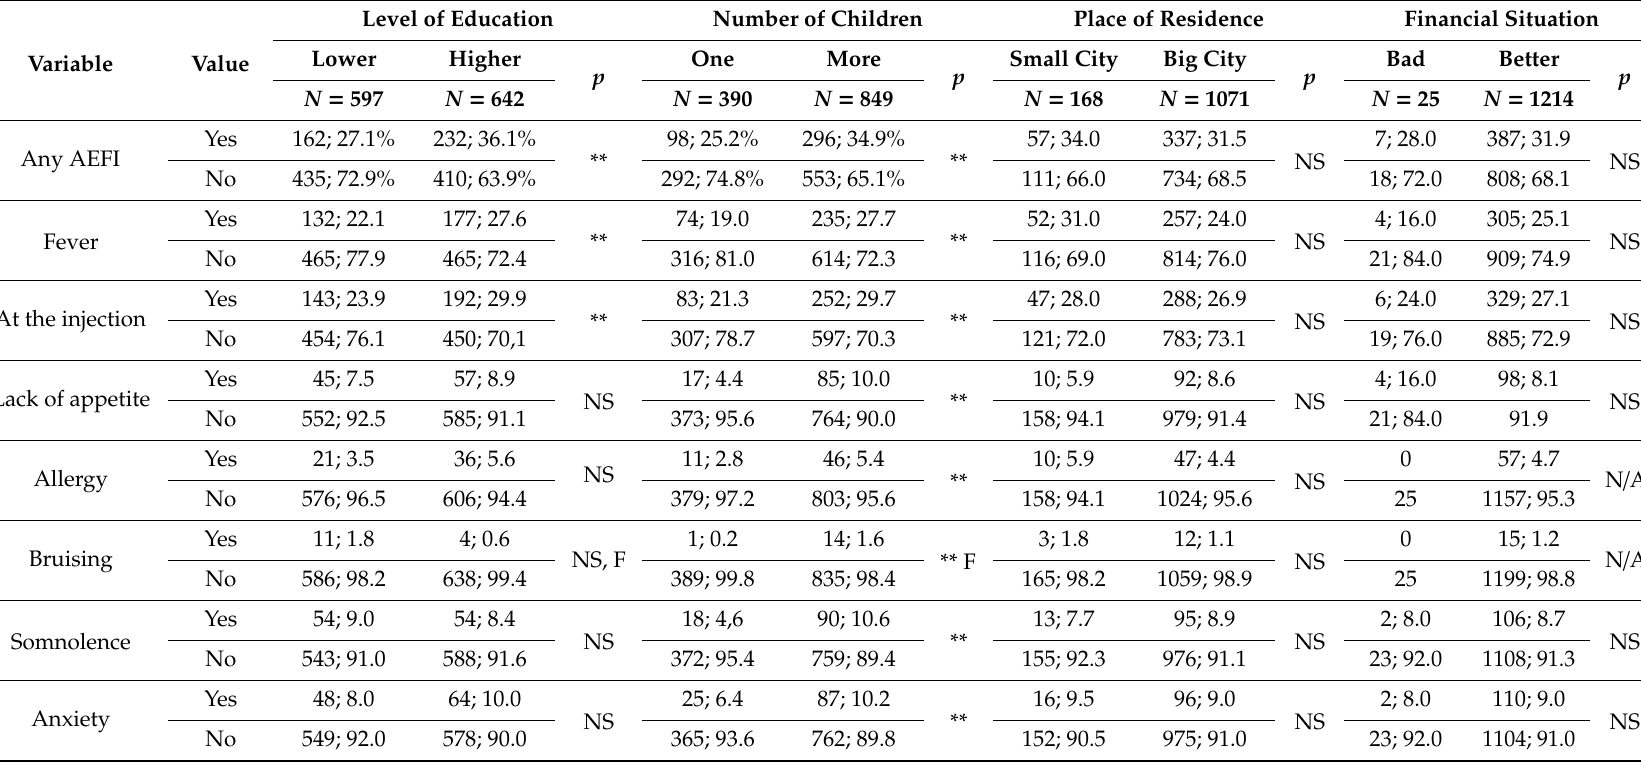
Table 1. The detailed proportion of declared AEFI occurrence regarding the simplified categories of variables